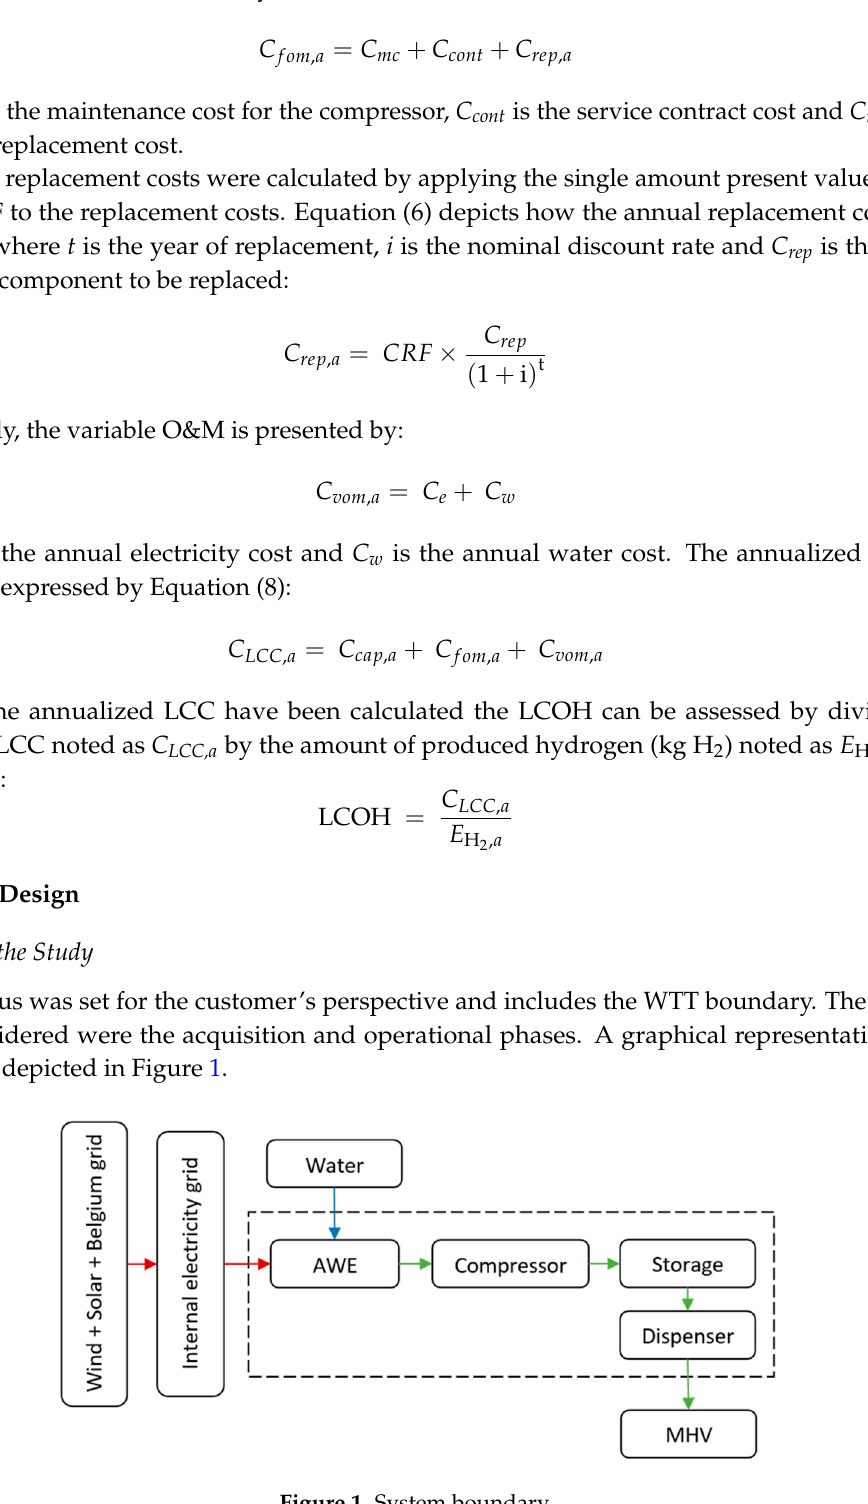
Figure 1. System boundary.